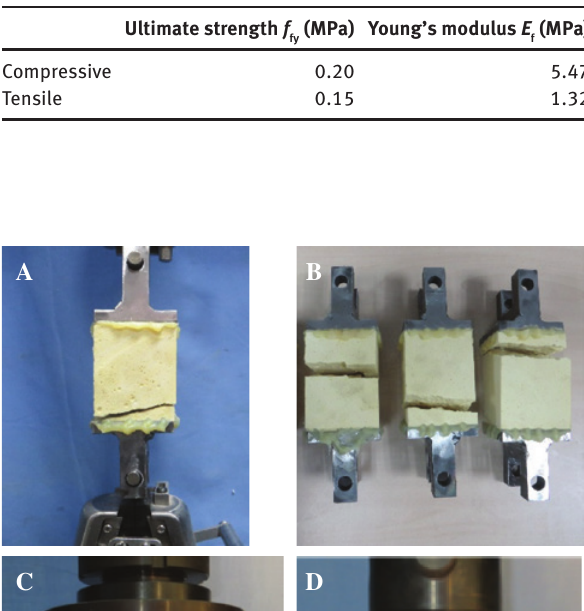
Table 2: Material properties of foam.